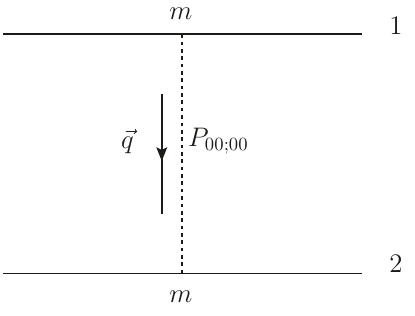
Figure 10 . The diagram that gives the newtonian potential in the NR-EFT language. The two horizontal solid lines (labeled 1 and 2) represent the world line of the two black holes with masses m 1 and m 2 , respectively. The dotted line between the two black holes represents a potential graviton H , with 3-momentum ~q . For the newtonian potential, only the P 00;00 component of the potential graviton propagator